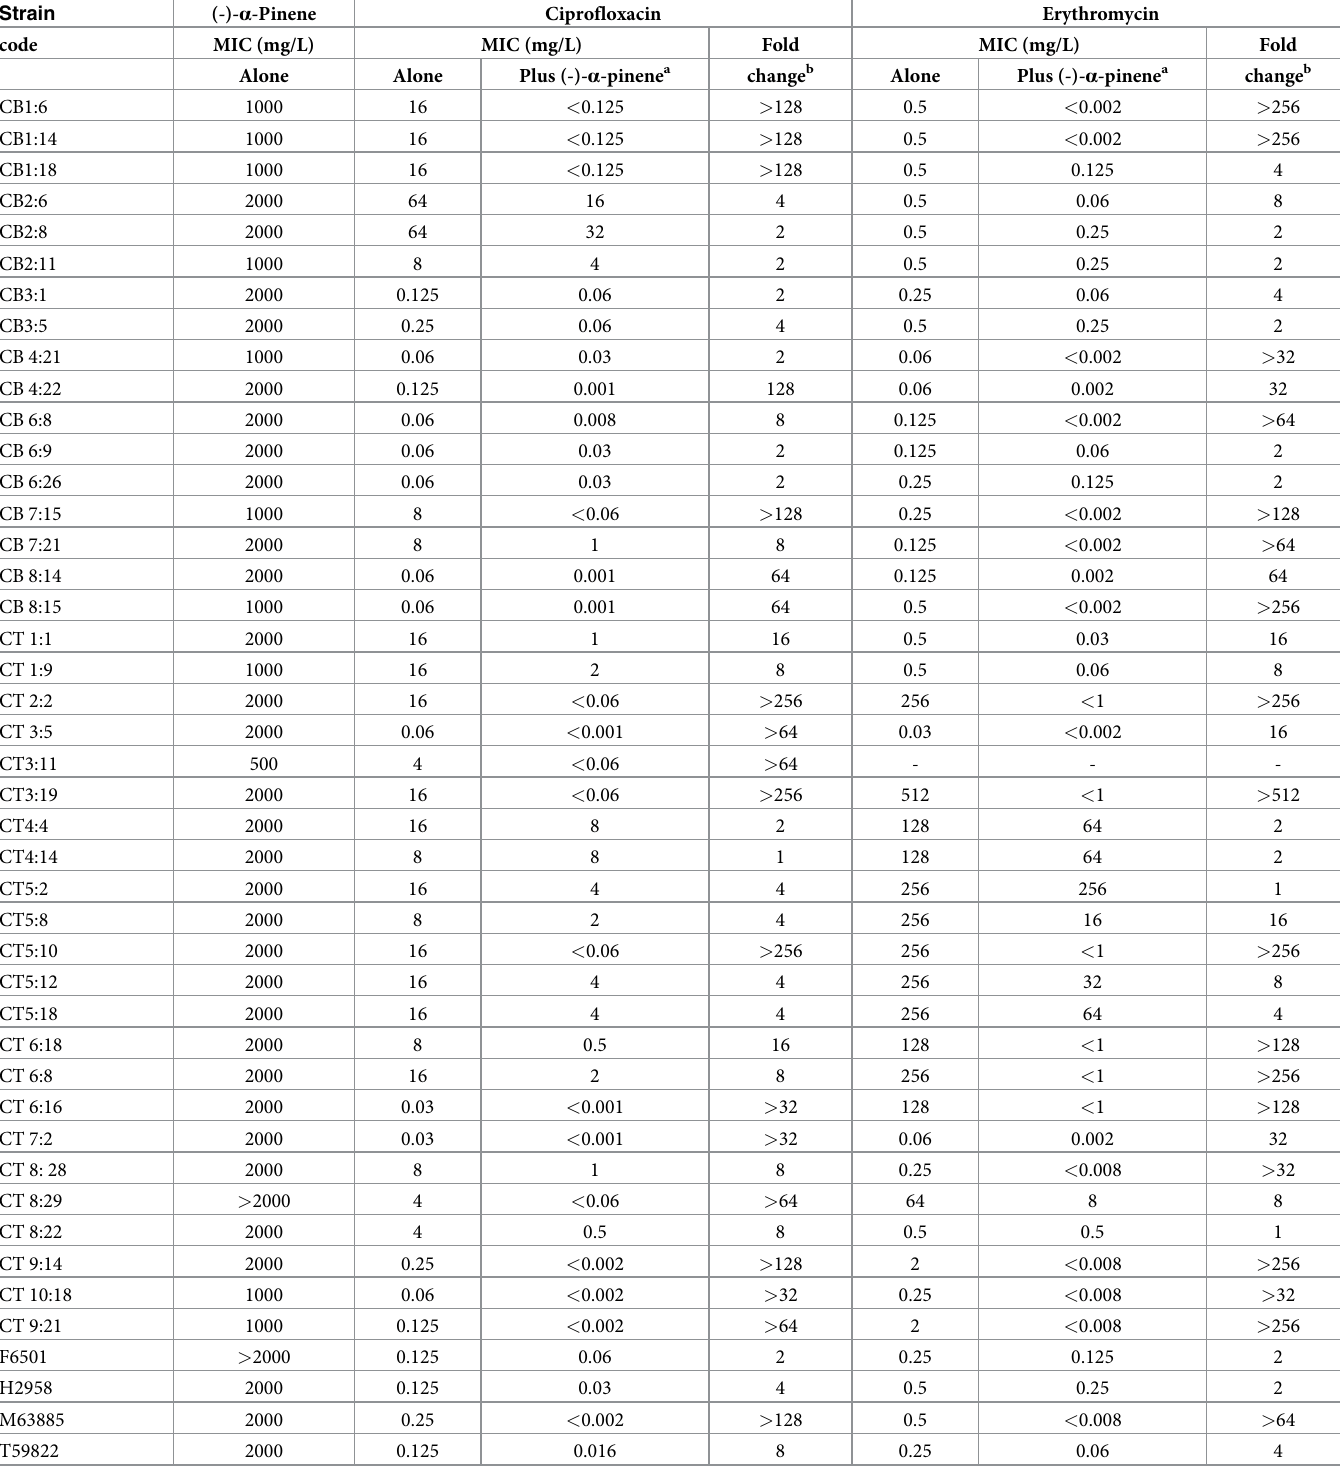
Table 1. Antimicrobial and resistance modulatory activity of (-)- α -pinene with antibiotics ciprofloxacin and erythromycin in 57 Campylobacter jejuni strains from chicken meat (strain code, CB), turkey meat (strain code, CT), human feces (strain codes F, X) and the reference strain NCTC 11168. Strain (-)- α -Pinene Ciprofloxacin Erythromycin